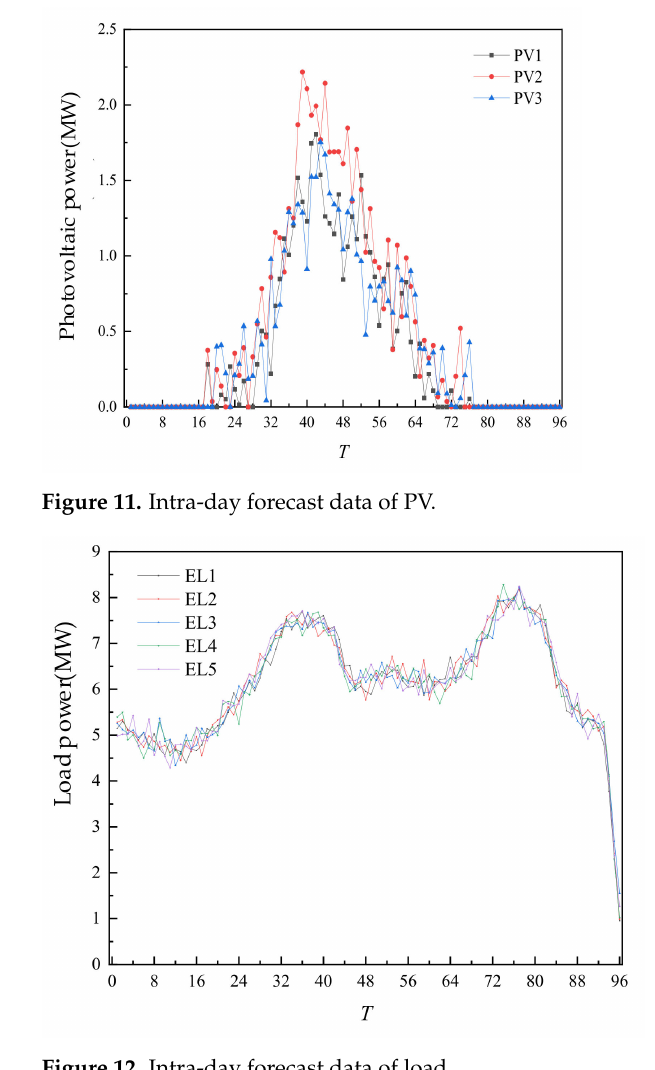
Figure 12. Intra-day forecast data of load.